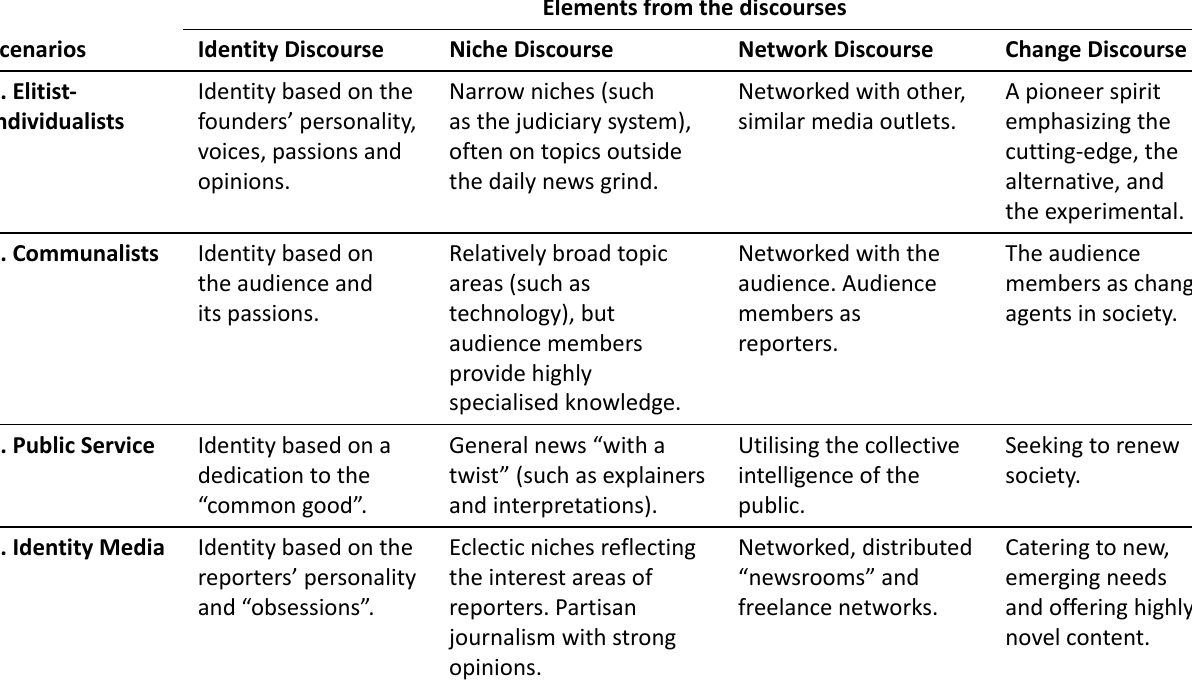
Table 1. Scenario sketches of entrepreneurial hybrid journalism in